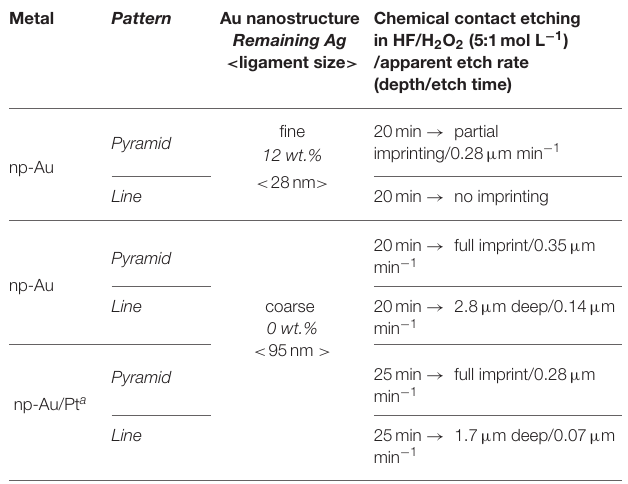
TABLE 3 | Etching conditions and results obtained by chemical contact etching using np-Au and np-Au/Pt electrodes with pyramid and U-shaped line arrays as surface patterns ( cf. Supplementary Information for more details on contact etching